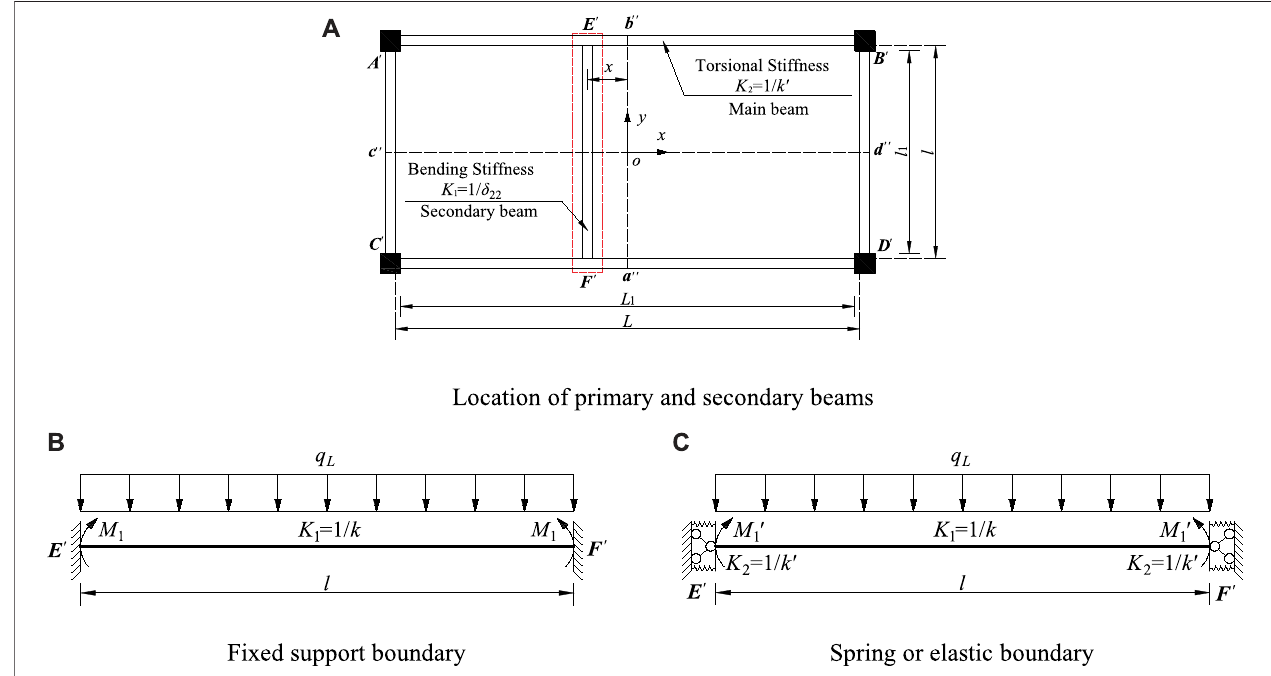
FIGURE5 | Simpli fi ed models for negative bending ofslab edge under elastic condition (A) Location ofprimary and secondary beams (B) Fixed support boundary (C) Spring or elastic boundary.